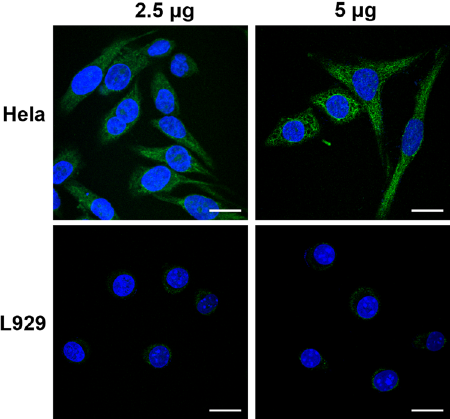
Fig. 5 FR expression in HeLa and L929 cells. Treated with 2.5 or 5 μ g of anti-FOLR1 antibody, respectively. The images are overlaid with the green color of the FITC-tagged secondary antibody and the blue color of nuclei stained with Hoechst 33258. Scale bars, 20 μ